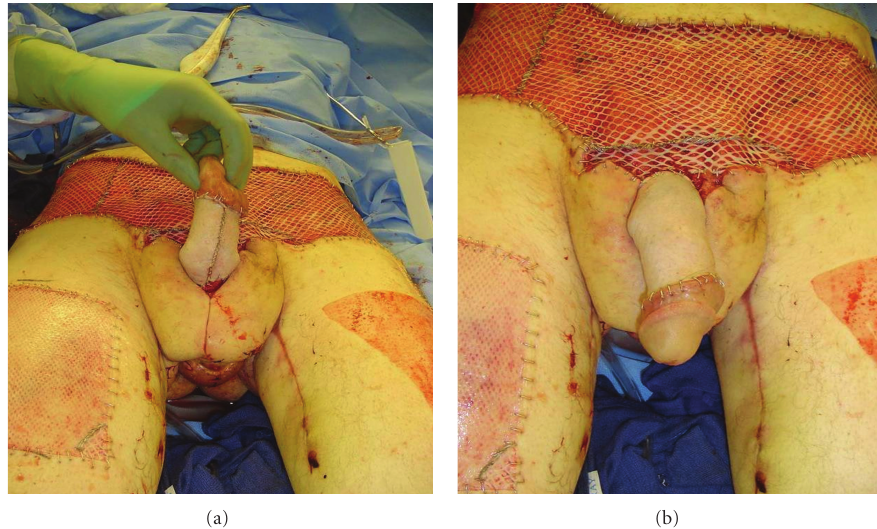
Figure 5: Full-thickness skin graft with 3:1 mesh was used to cover lower abdominal wound, while a thick-split-thickness skin graft was used to cover penile shaft skin loss. Allograft skin was obtained from the patient’s thighs.